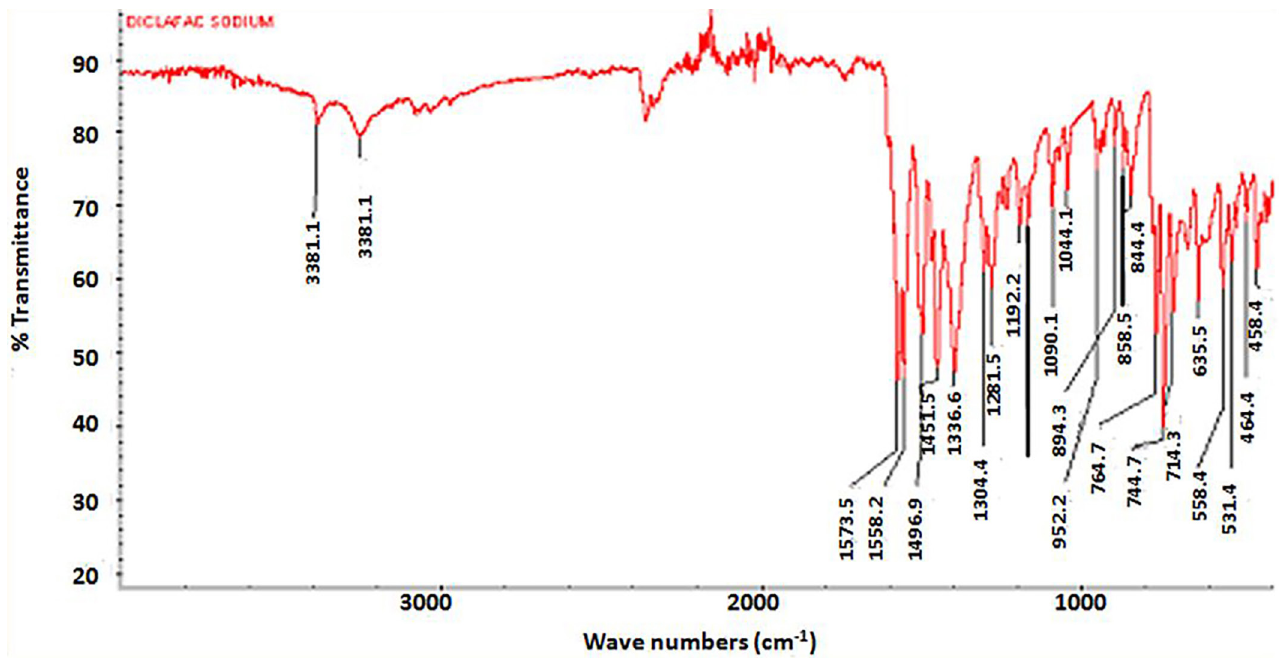
FIGURA 2 - FTIR Spectrum of diclofenac sodium.